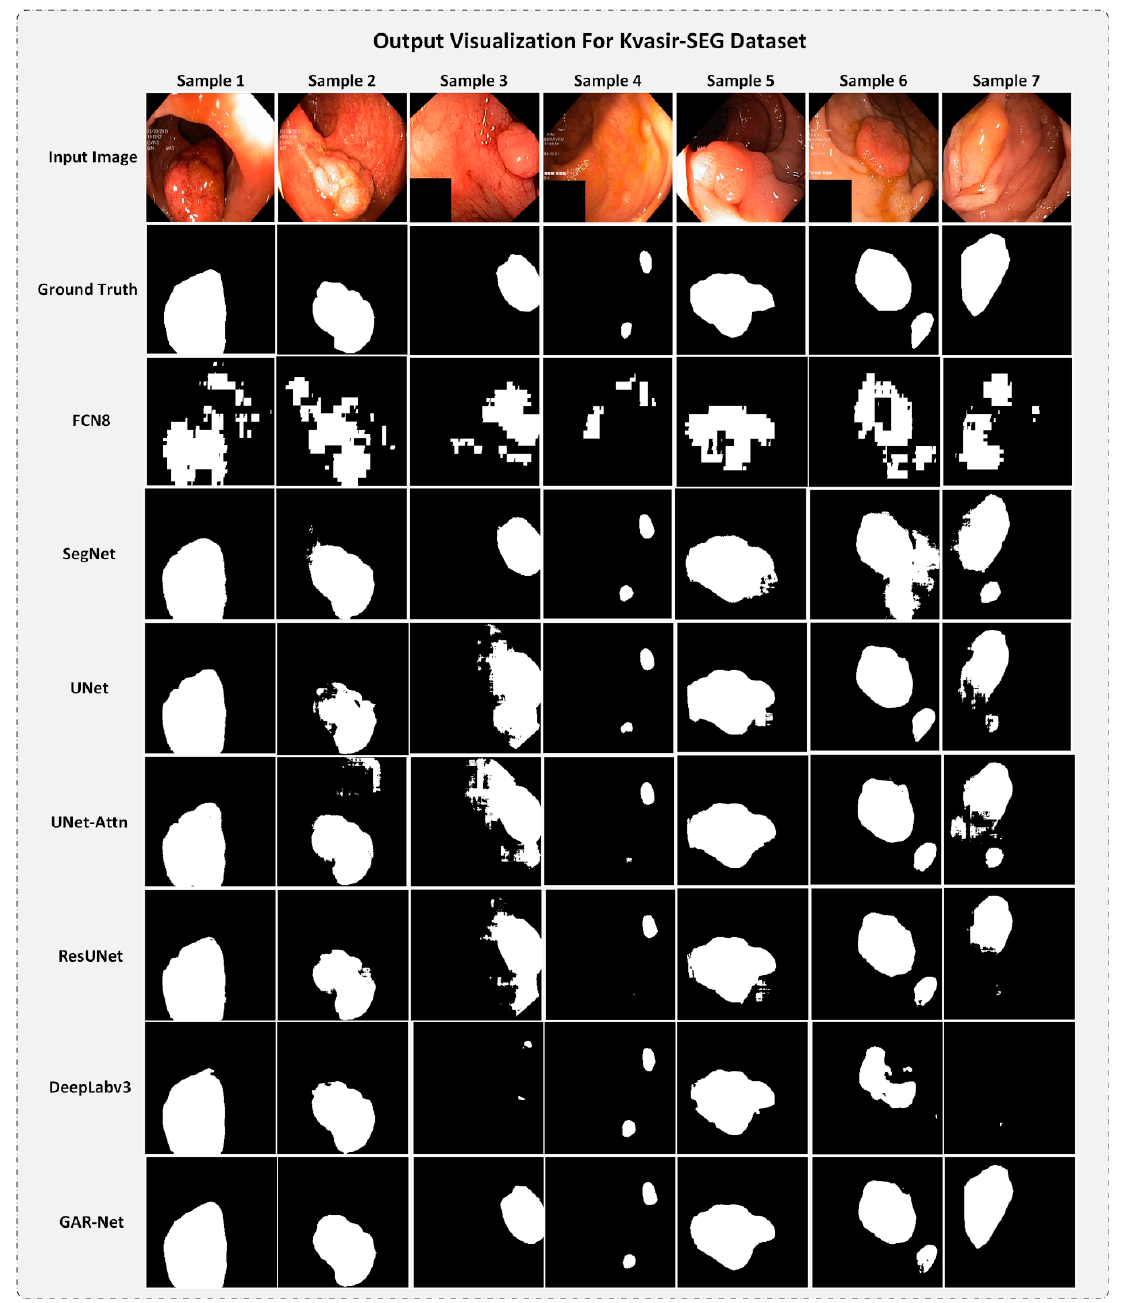
Figure 8. The output comparison for all the models on the Kvasir-SEG